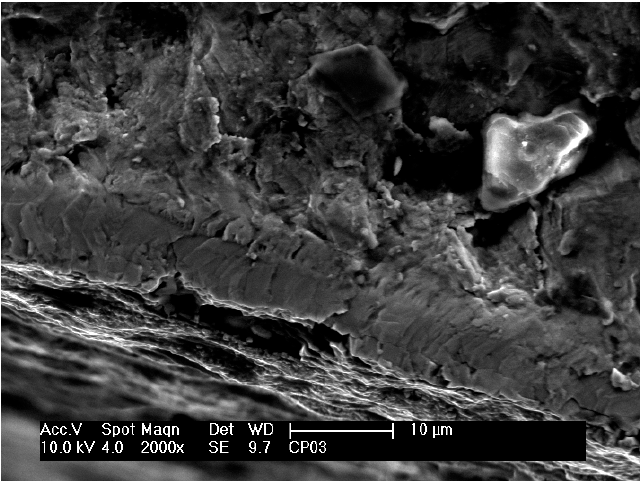
Figure 8. Scanning electron micrograph of the fracture surface of the plasma nitrided specimen that was fatigue tested at 610 MPa and 233,000 cycles to failure.